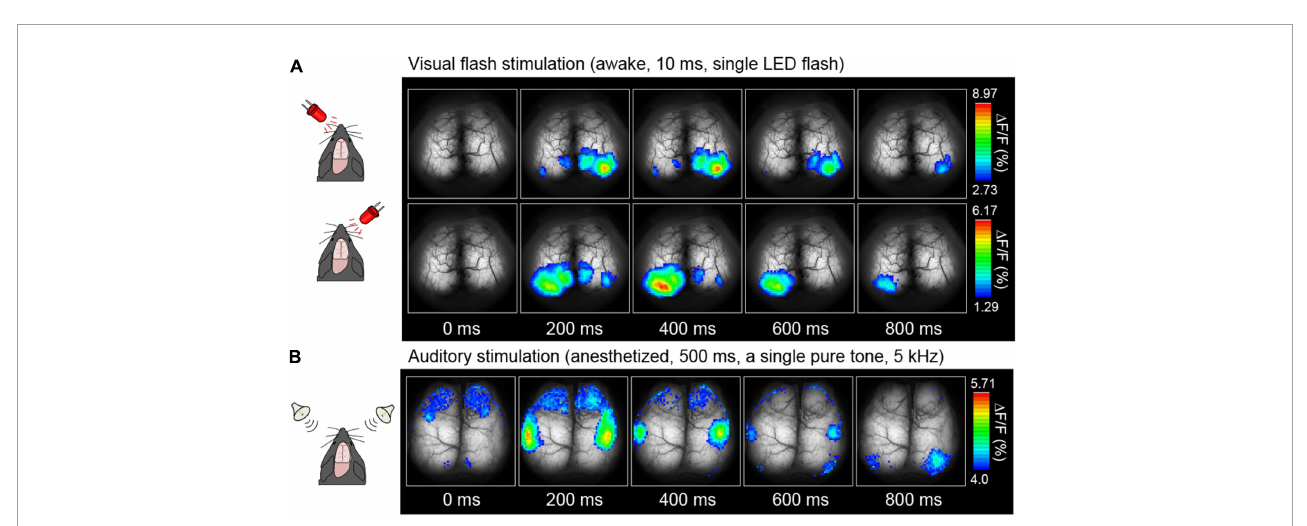
FIGURE4 Examples of cortical sensory mapping. Visual stimuli (A) and auditory stimuli (B) were applied. Pseudocolor is superimposed on the raw brain images, which represents the fluorescence change ratio. The sampling rate was 30 Hz [Modified from Monai et al.